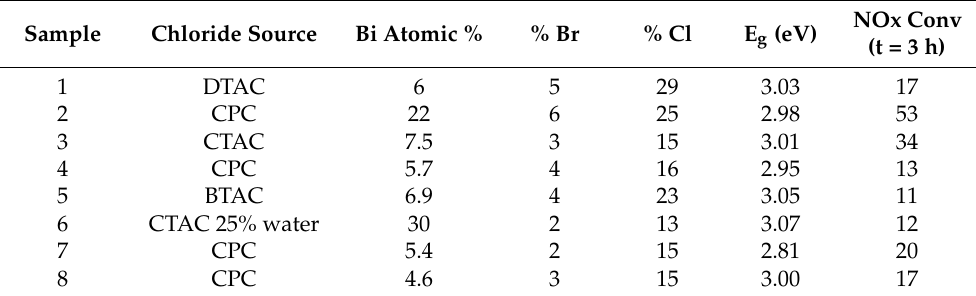
Table 2. Synopsis of XPS, bandgap, and catalytic activity for samples 1–8. For the atomic surface, the remaining component is